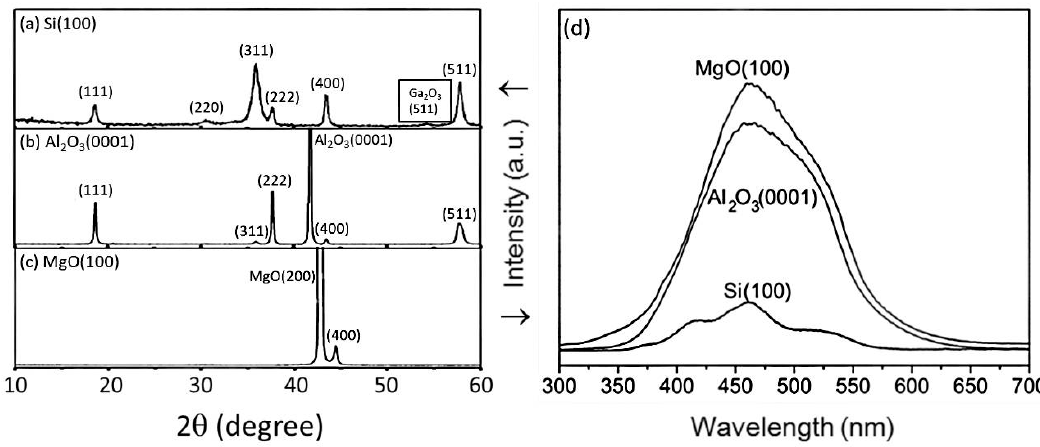
Figure 6. XRD pattern of ZnGa 2 O 4 thin film deposited on: ( a ) Si(100) substrate; ( b ) Al 2 O 3 (0001) substrate; ( c ) MgO(100) substrate; ( d ) room temperature PL spectra of ZnGa 2 O 4 films grown on these substrates (substrate temperature: 550 °C and oxygen pressure: 100 mTorr by PLD) [80] (with copyright permission from Elsevier, 2020).